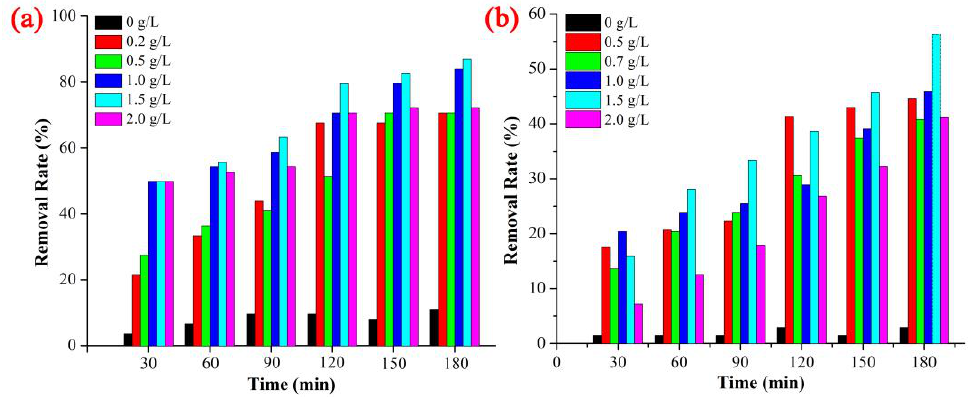
Figure 6. Effect of ZnO NPs dose on the photocatalytic degradation of MO ( a ) and PNP ( b ).